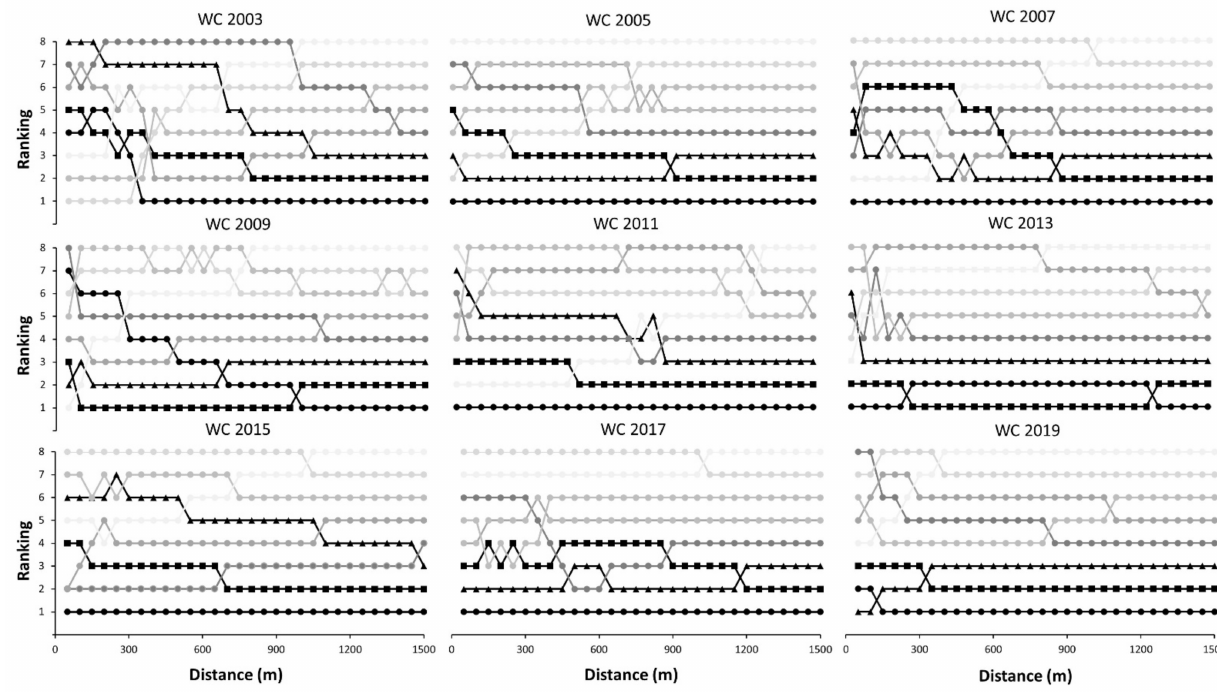
Figure 4. Positioning of female swimmers across 1500 m freestyle races of the World Championships (from 2003 and 2019) according to their final position in the race. WC: World